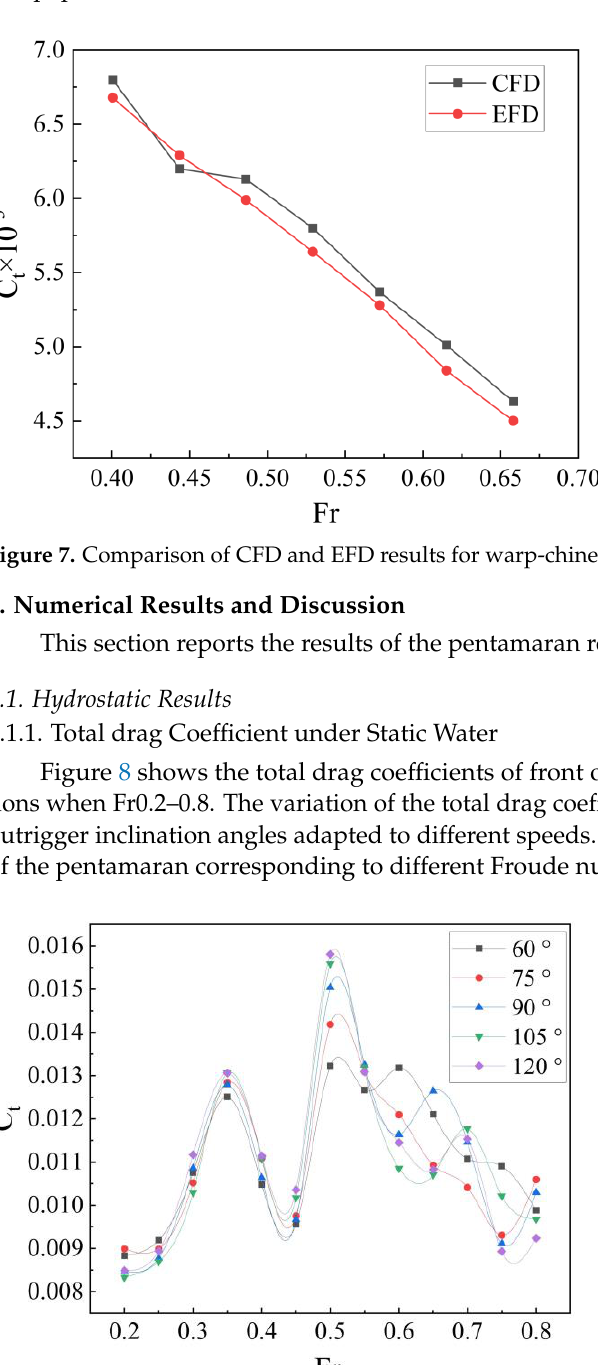
Figure 8. Total resistance coefficient at different Froude number.